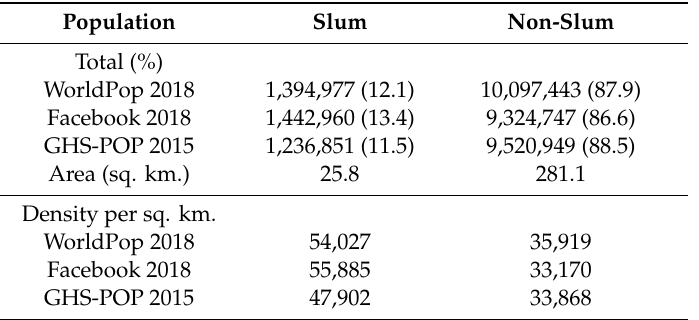
Table 3. Total population and population density in Dhaka, Bangladesh according to three secondary population